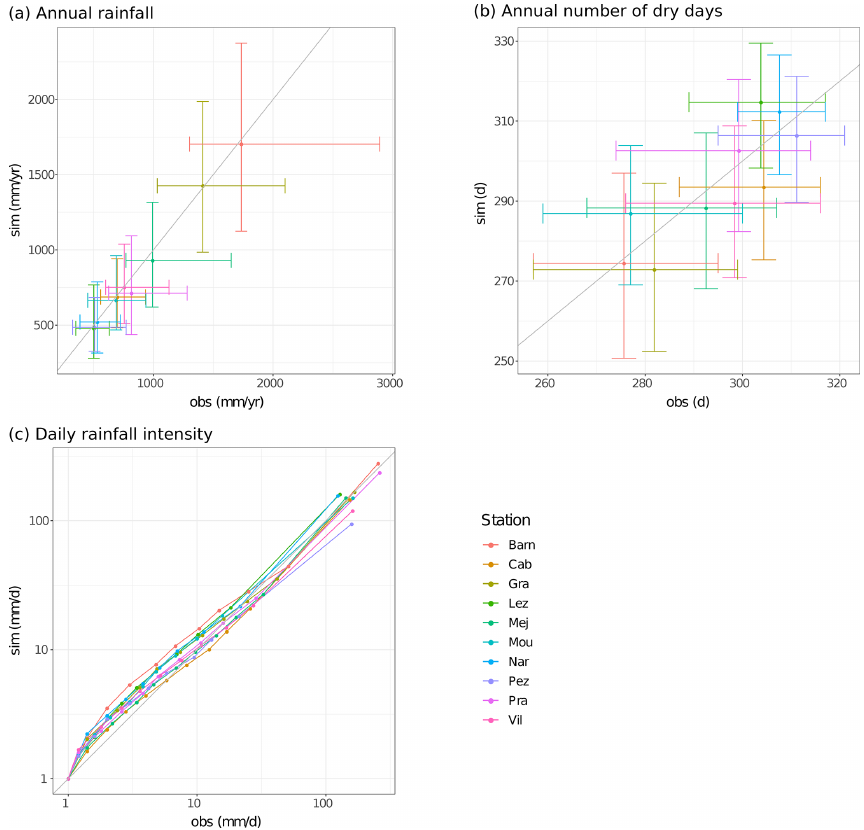
Figure 4. Characteristics of simulated rainfall with the NSRP model for the reference scenario and observed rainfall. Comparison of simulated and observed (a) annual rainfall and (b) annual number of dry days (dots represent mean values and bars represent the range from minimal to maximal simulated or observed values). (c) Q–Q plot of daily rainfall intensities (dots represent deciles